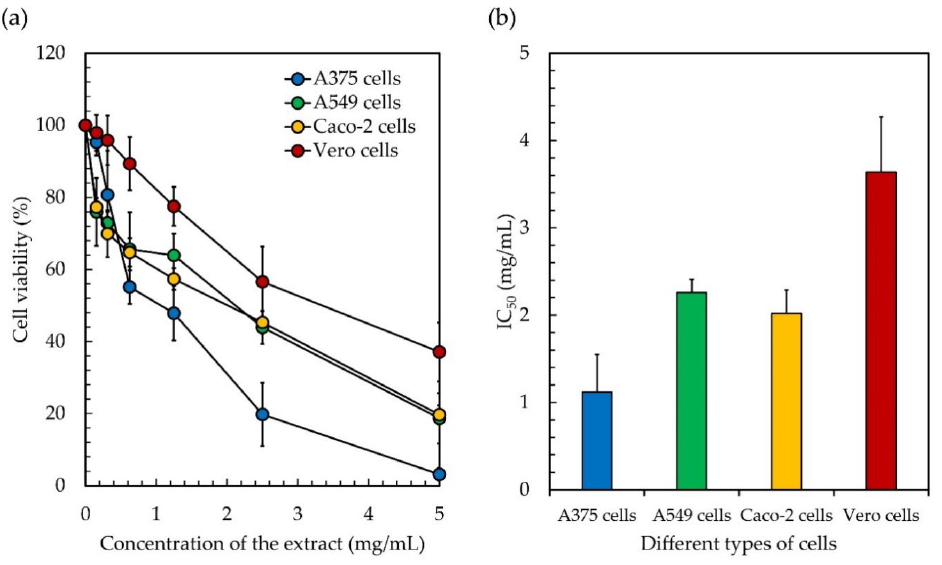
Figure 4. The cytotoxicity of skin cancer A375 cells, lung cancer A549 cells, and colon cancer Caco-2 cells after treatment with the ethanolic extract from cyanobacteria, Leptolyngbya sp. KC45 when compared with control cells, i.e., normal Vero cells, for 48 h. Cell viability was measured using the 3-(4,5-Dimethylthiazol-2-yl)-2,5-diphenyltetrazolium bromide reduction (MTT) assay ( a ) and calculated for comparisons with the control cells ( b ).